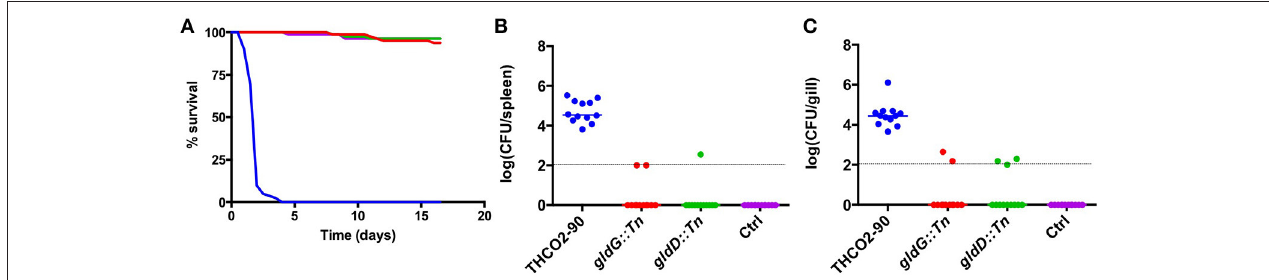
FIGURE 5 | Experimental immersion challenge. (A) Rainbow trout survival following infection by immersion challenge with F. psychrophilum . Fish were infected for 24h with 5 × 10 6 CFU mL − 1 in a final volume of 15L with strains THCO2-90 (blue), gldG::Tn (red), and gldD::Tn (green). (B,C) Bacterial load of rainbow trout infected with strains THCO2-90, gldG::Tn and gldD::Tn . Six fish infected by each strain were sacrificed at 4h post-infection. The bacterial loads of spleen (B) and gills (C) are shown. The results of two independent experiments are